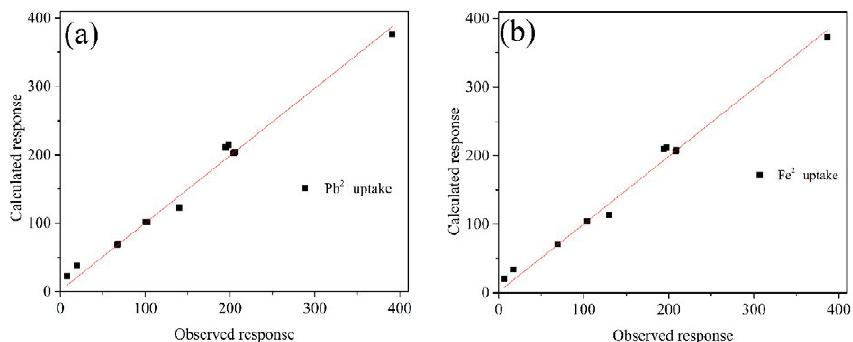
Fig. 5: Comparison of experimental and calculated responses for (a) Pb 2+ and (b) Fe 2+ metal ions removal.